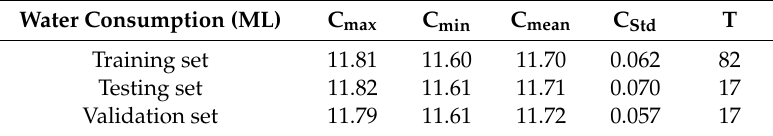
Table 2. Statistical parameters for training, testing, and validation sets.